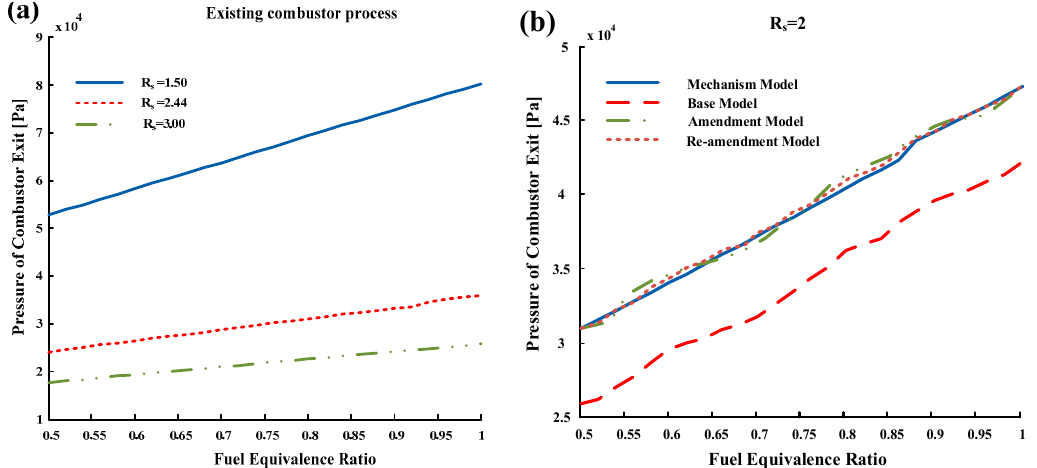
Figure 3. Simulation of the total pressure of the outflow fluid with 25 data pairs. ( a ) existing combustors; ( b ) simulation of the new